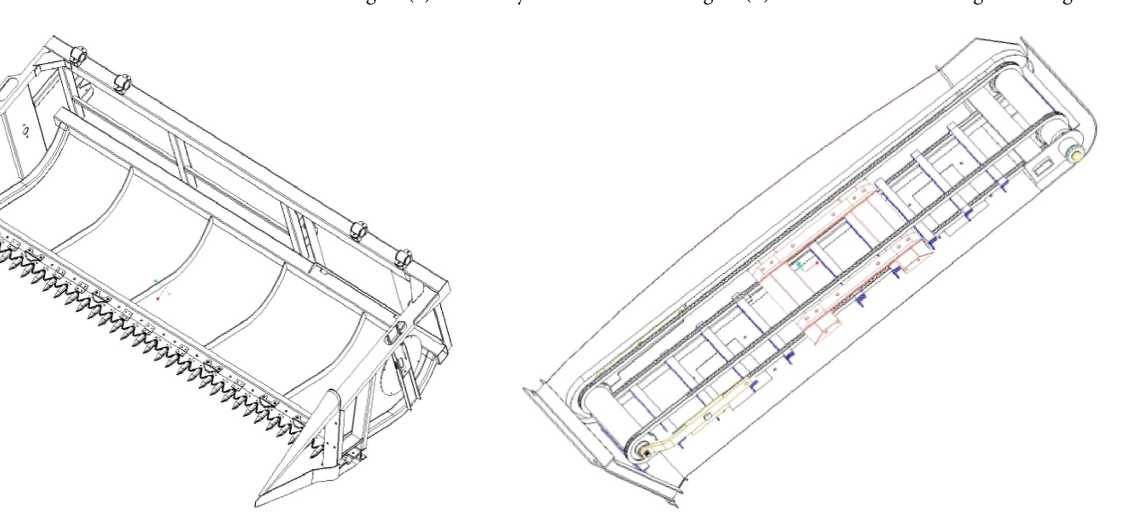
Figure 4: Structure and schematic of the combine auger. (a) Assembly of the combine auger. (b) Eccentric retractable grilled fingers.